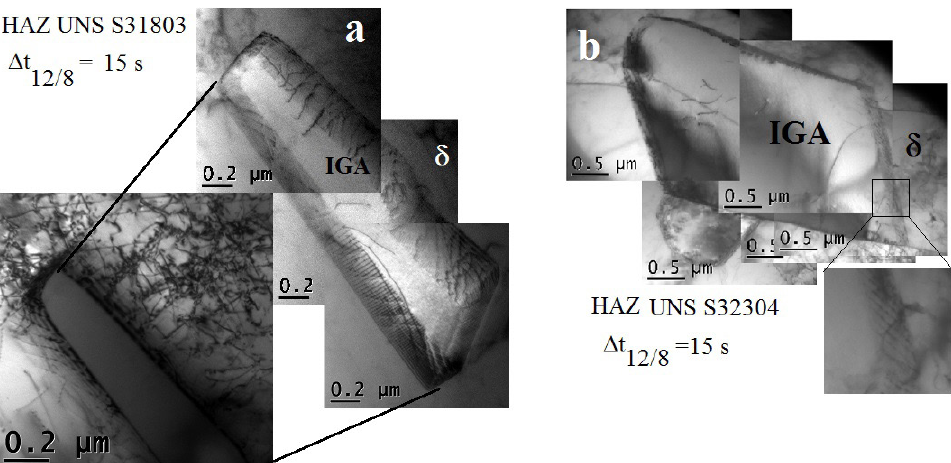
Figure 4. TEM bright field images of two representative IGA particles corresponding to the HAZs with the shorter cooling time of both DSS. The misfit dislocations can be observed at the broad faces. ( Figure 4a in Morales et al. 19 ).